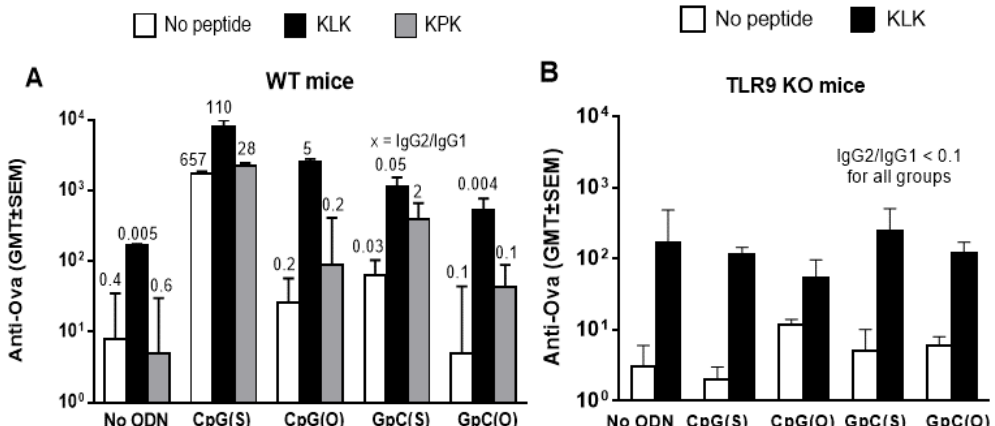
Figure 1. Wild type C57Bl/6 (Panel A) or TLR9 deficient (Panel B) mice ( n = 5/group) were immunized at week 0, 2 and 3 by IM injection with unadjuvanted OVA (10 µ g) or OVA adjuvanted with CpG(S), CpG(O), GpC(S), GpC(O) ODN (4 nmol) alone or in combination with KLK or KPK (only WT mice) peptides (100 nmol). Each bar represents the group geometric mean ( ˘ SEM) of the titer for OVA-specific antibodies (anti-OVA IgG) in plasma taken 1 week after final immunization. Numbers above each bar indicate the IgG2c/IgG1 isotype ratio.